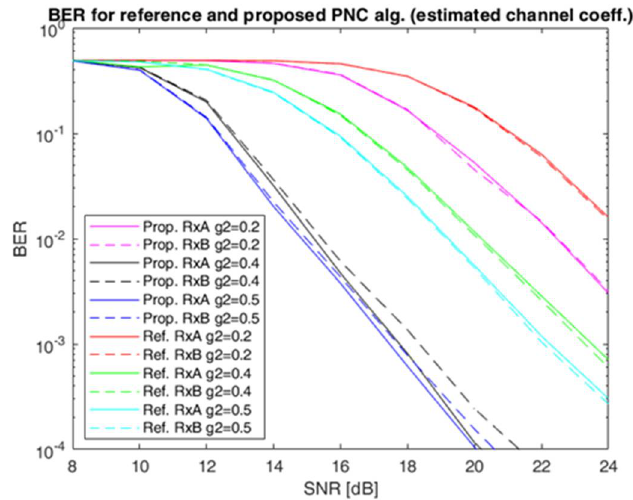
Figure 10. BER on the output of the receivers of terminals A and B for the proposed and reference PNC algorithms for the number of N p = 6 OFDM pilot symbols used in channel estimation (small values of g 2